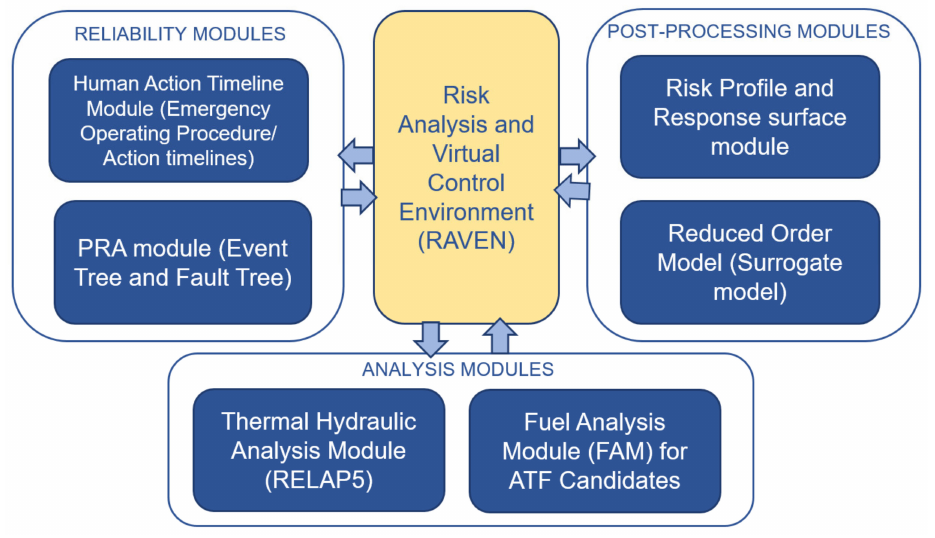
Figure 2. Dynamic Risk Assessment